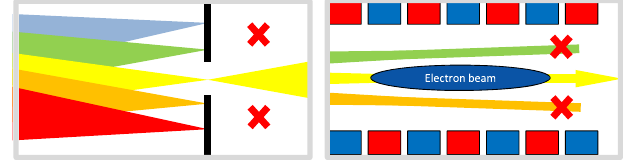
FIG. 14. Physical slit (left figure) blocks undesired wavelengths, passing through only certain bandwidth. It is easily controlled and may be moved out. Since radiation amplification in an undulator takes place via interaction with accelerated electrons, only a radiation overlapped over the electron beam will be amplified. It can be expressed as a virtual slit (right figure). This process is barely controlled and cannot be “ turned off.